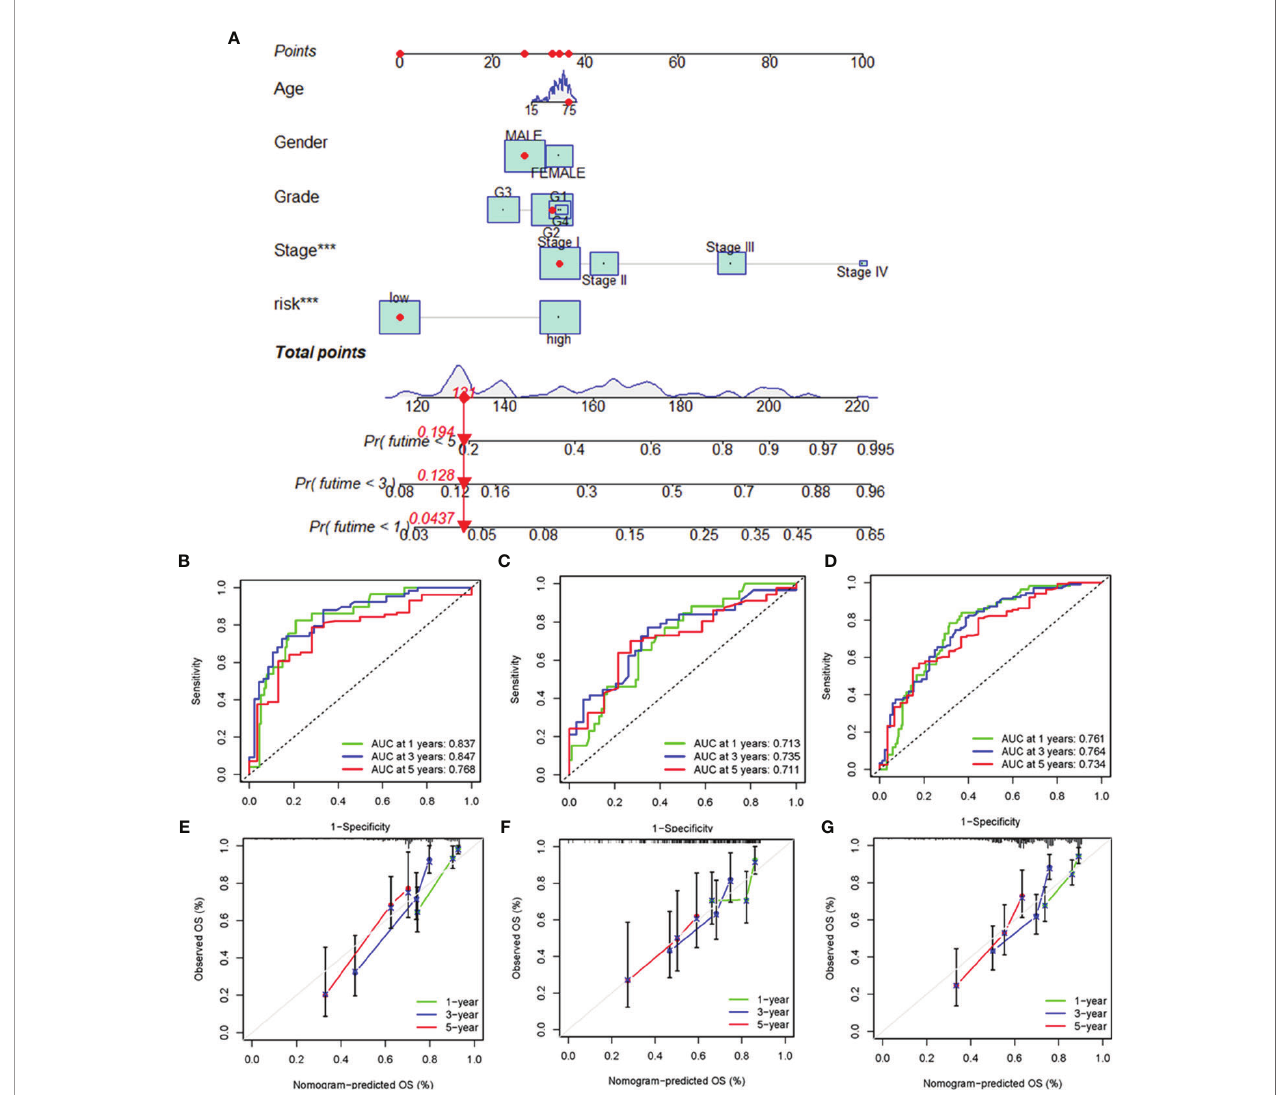
FIGURE 6 | Construction and evaluation of the nomogram for clinicopathological characteristics and risk signature. (A) Nomogram combining PRlncSig and clinicopathological characteristics for predicting prognosis of HCC patients in the training cohort. ROC analysis of the predictions of 1-, 3-, and 5-year survival by the nomogram in the training cohort (B) , testing cohort (C) , and entire cohort (D) . Calibration curve analysis of the nomogram for the probability of overall survival at 1, 3, and 5 years in the training cohort (E) , testing cohort (F) , and entire cohort (G) . *** P <